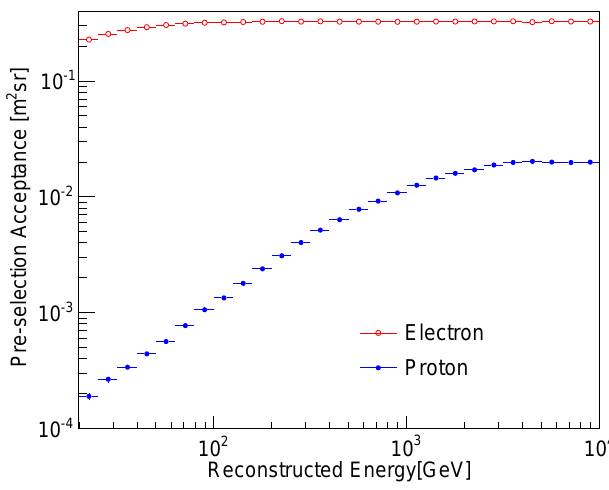
Figure 1. The pre-selection acceptance of electrons and